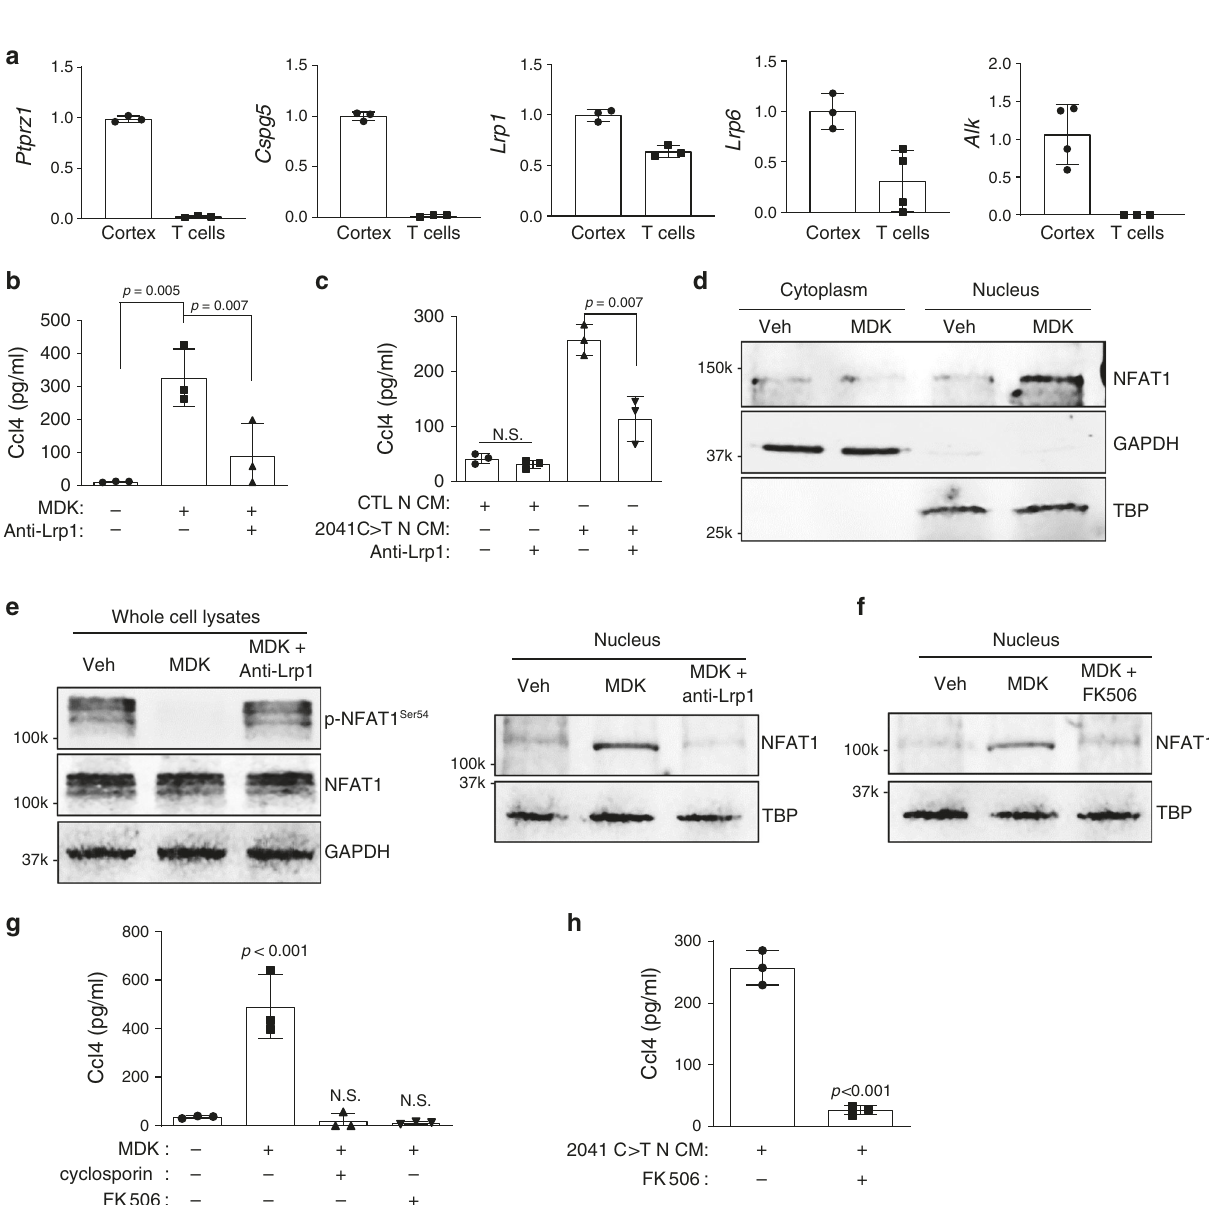
Fig. 3 MDK activates T cells to produce Ccl4 through Lrp1/calcineurin/NFAT1 signaling. a T cells expressed only two (Lrp1 and Lrp6) of the putative MDK receptors [protein-tyrosine phosphatase ζ ( Ptprz1 ), neuroglycan-C ( Cspg5 ), low density-lipoprotein receptor-related protein-1 ( Lrp1 ), low density- lipoprotein receptor-related protein-6 ( Lrp6 ) and anaplastic lymphoma kinase ( Alk )] by quantitative RT-PCR. Normal mouse cortex was used as an internal positive control. b Lrp1 blocking antibodies (30 µ g ml − 1 ) reduced MDK-induced Ccl4 production in T cells. c The 2041C>T neuron conditioned media (N- CM)-mediated Ccl4 production in T cells was attenuated following exposure to Lrp1 receptor blocking antibodies. d Immunoblotting revealed increased NFAT1 nuclear localization in T cells following MDK treatment. Glyceraldehyde 3-phosphate dehydrogenase (GAPDH) and TATA-binding protein (TBP) served as loading controls for the cytoplasm and nuclear fractions, respectively. e Decreased levels of phosphorylated-NFAT1 (p-NFAT) were observed after MDK stimulation of T cells. Lrp1 blocking antibodies (anti-Lrp1, 30 µ g ml − 1 ) increased NFAT1 phosphorylation and impaired NFAT1 nuclear localization in MDK-stimulated T cells. f The calcineurin inhibitor FK506 (10 μ M) inhibited MDK-induced NFAT1 nuclear localization. g Calcineurin inhibitors, cyclosporin (100 nM) and FK506 (10 μ M), inhibited MDK-induced Ccl4 production in T cells. h FK506 (10 μ M) reduced 2041C>T neuron conditioned media (N-CM)-induced Ccl4 production in T cells. All data are presented as the mean ± SEM. a Bar graphs represent the means ± SEM of n = 3 independent biological samples. b , c ; g , h These representative experiments were conducted with n = 3 independent biological samples,and were replicated two additional times with similar results. b , c , g One-way ANOVA with Bonferroni post-test correction, h Two-tailed Student ’ s t -test. Exact P values are indicated within each panel; N.S.; not signi fi cant. From left to right in each panel: b P = 0.005, P = 0.007; c N.S., P = 0.007; g P < 0.001, N.S., N.S.; h P < 0.001. d – f These are representative images of n = 3 independent biological samples examined over three independent experiments with similar results. Molecular weight markers are denoted at the left side of each